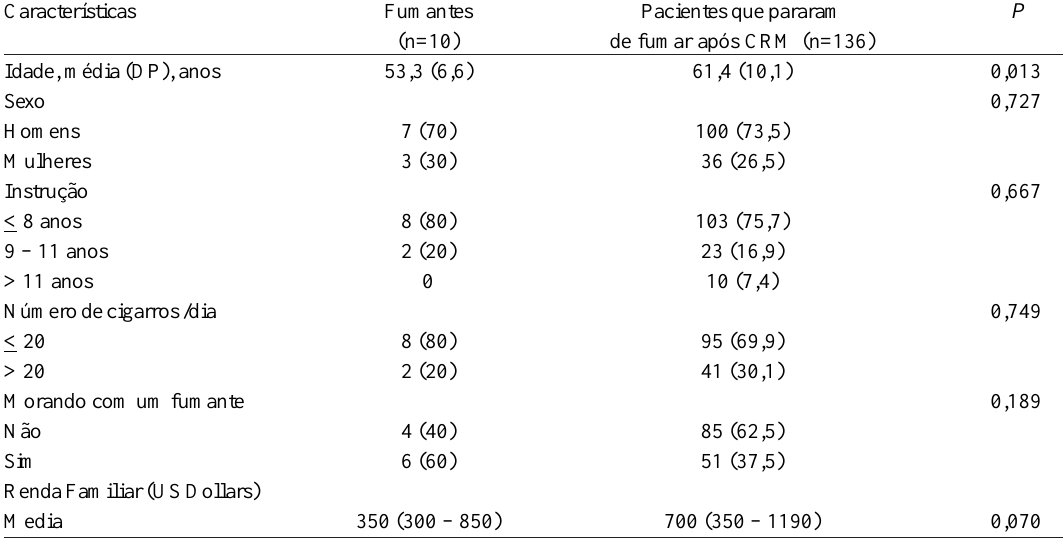
Tabela 2. Características de pacientes fumantes submetidos à cirurgia de revascularização do miocárdio, estratificados de